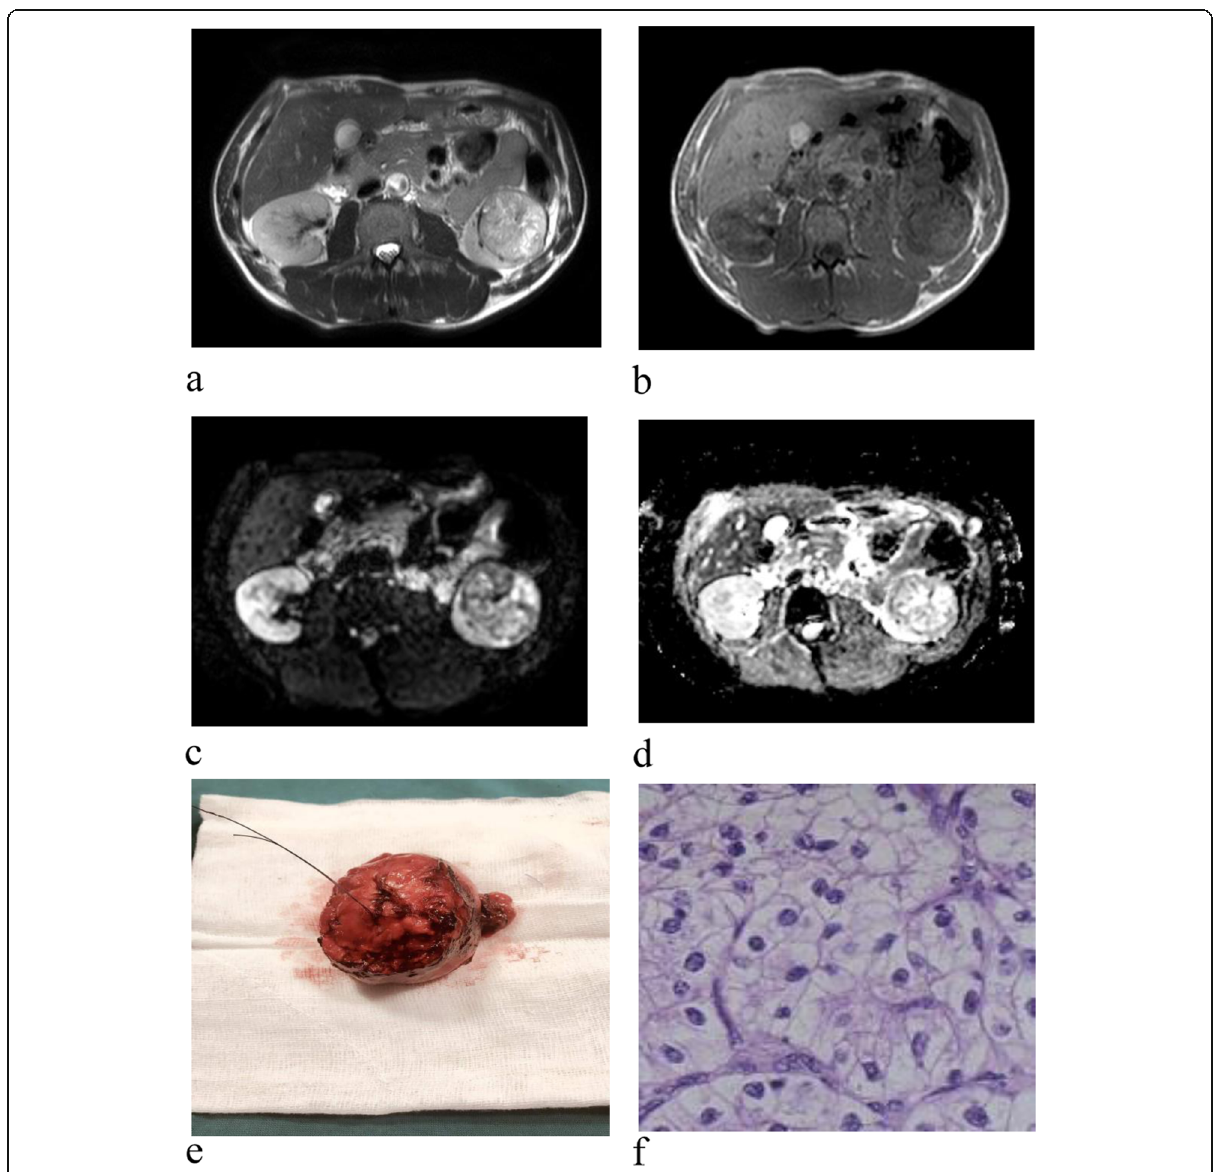
Fig. 8 A 59-year-old male patient with accidental detection of a left renal mass on ultrasound during surveillance for HCC. MRI revealed a left lower zonal heterogeneous mass lesion. a T2WI, b T1WI, c and d DWI and ADC showing heterogeneous foci of diffusion restriction, ADC = 1.4 × 10 − 3 mm 2 /s, e and f gross and histo-pathological photograph H&E × 400, clear cell